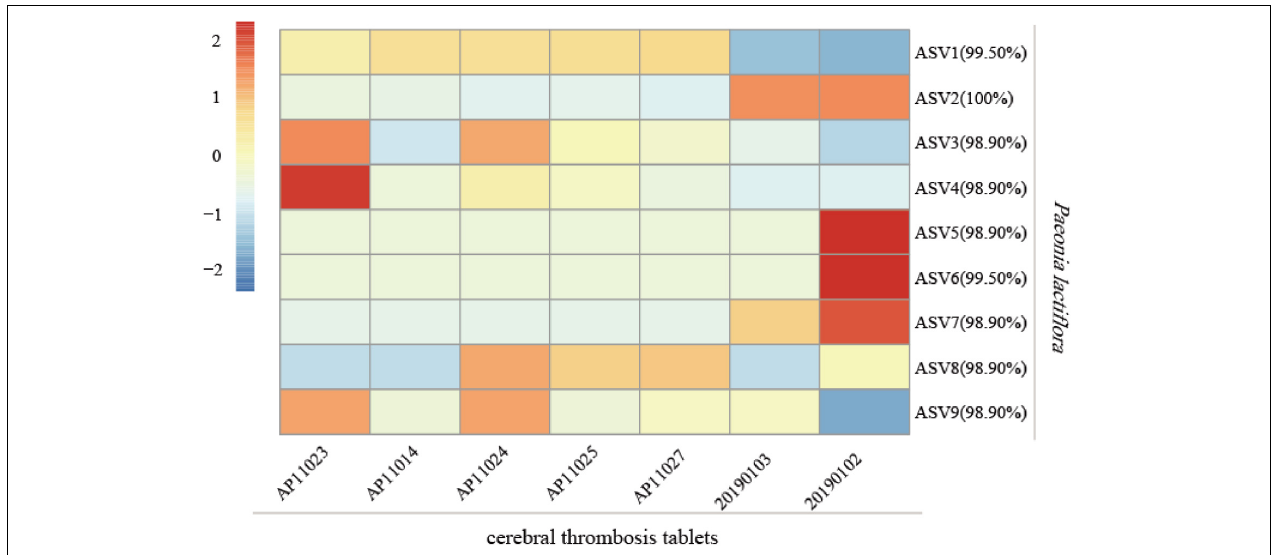
FIGURE 8 | Analysis of the species of Chishao in 7 batches of Chinese patent medicine “cerebral thrombosis tablets.” The read counts of sequencing data were normalized by Z-Score normalization. The formula for Z-Score was (X- mu)/sigma, where X was the read counts of each sample, mu and sigma were the mean value and standard deviation, respectively. The legend indicated the Z-score for each sample. The percentage besides amplicon sequence variants (ASV) number in the figure denoted the similarity between the representative sequences of ASV and the reference sequence.